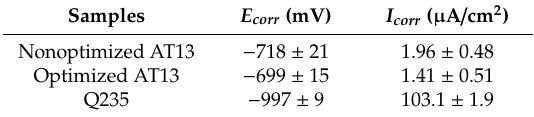
Figure 11. Potentiodynamic polarization curves of the AT13 coatings and Q235 substrate. Table 5. E corr and I corr calculated from the potentiodynamic polarization